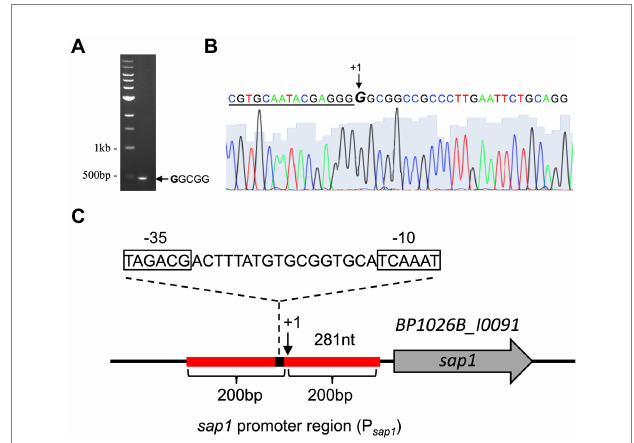
FIGURE 1 SMART RACE mapping identifies the transcriptional start site for sap1